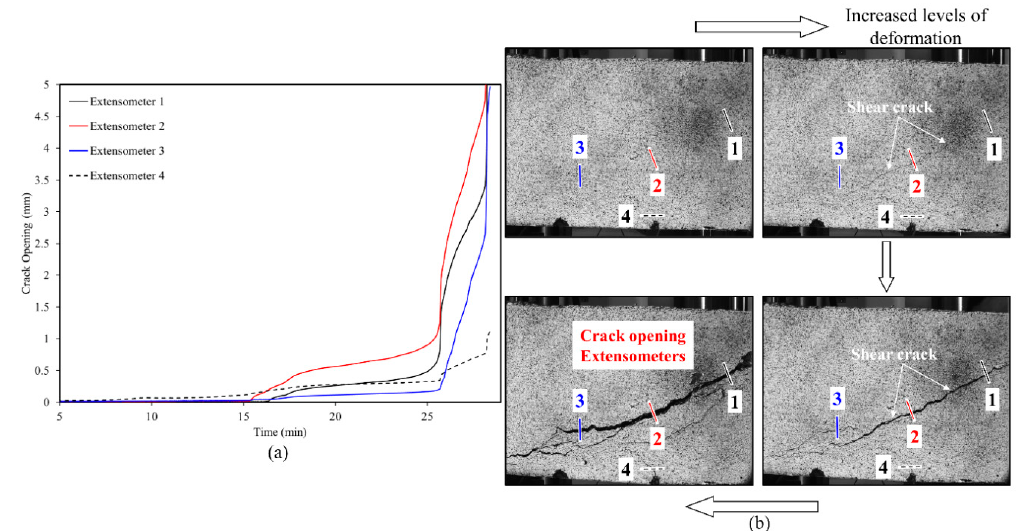
Figure 13. ( a ) Crack width versus time for the RCA-3D case shown in Figure 12. Results from 4 different VE are shown. ( b ) Optical images captured at different deformation levels. The locations of VE are shown. ( b ) Optical images captured at di ff erent deformation levels. The locations of the 4 VE the 4 VE across the length of the crack are marked. across the length of the crack are